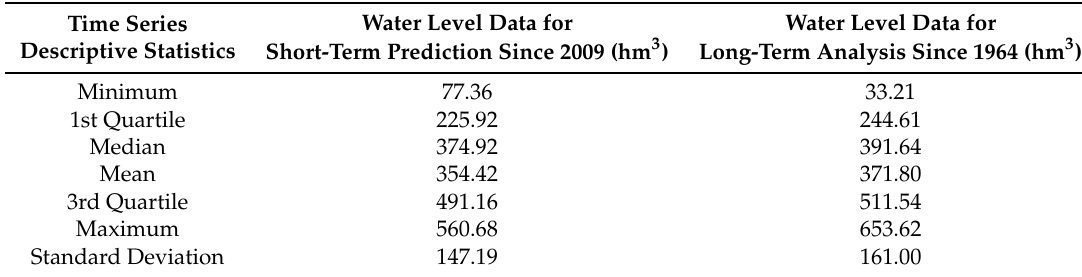
Table 1. Descriptive statistics for the dependent variable (water level at Belesar reservoir) for both problems presented in this paper: long-term prediction and analysis (time series since 1964) and short-term prediction (time series since